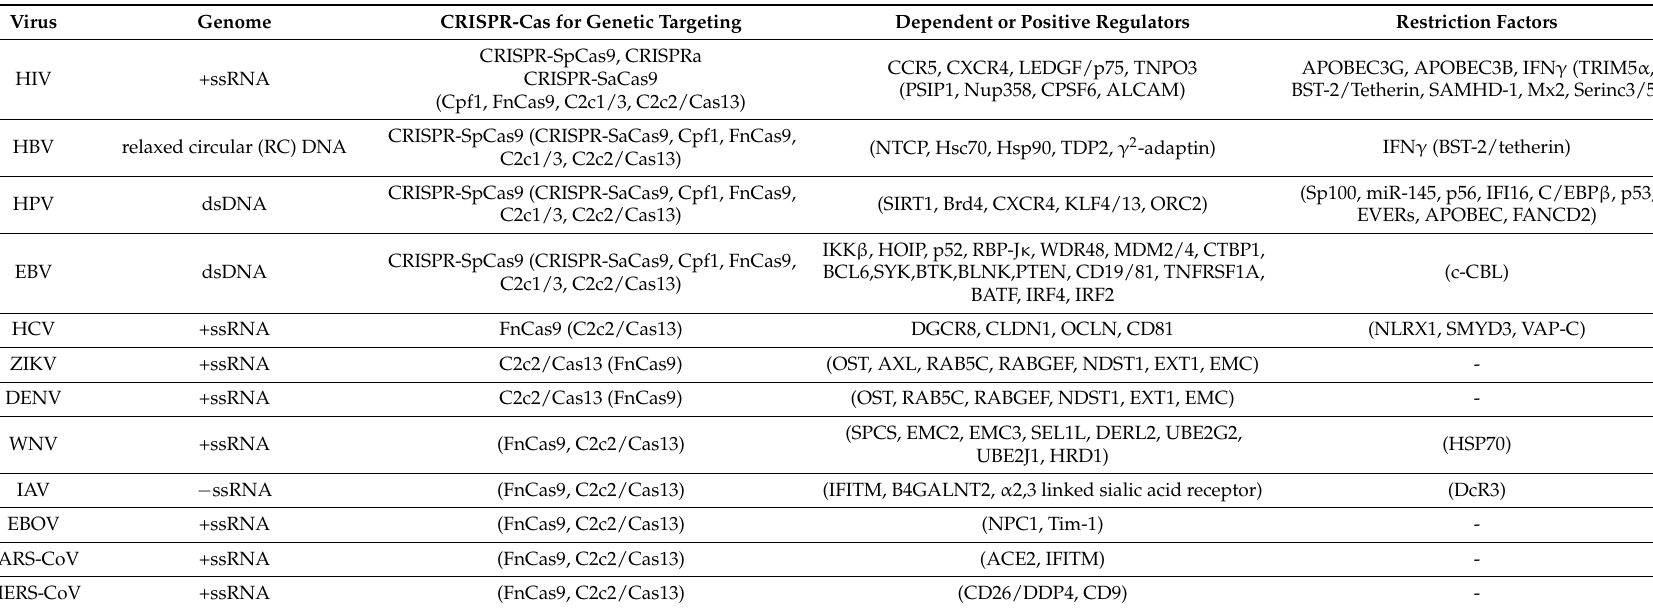
Table 2. Potential anti-viral host factors for targeting by CRISPR-Cas